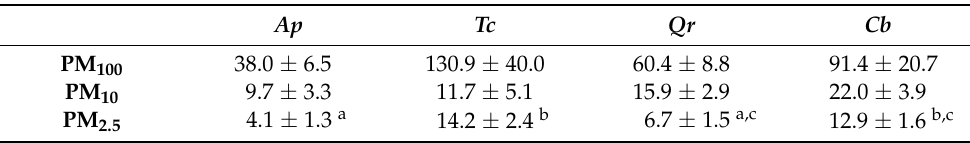
Table 2. Particulate matter (PM) fractions removed from leaves of A. platanoides ( Ap ), T. cordata ( Tc ), Q. robur ( Qr ), C. betulus ( Cb ) for the PM classes PM 100 , PM 10 , PM 2.5 . Data shown in mg PM · m − 2 leaf area ± standard error (SE). The letters mark the significant differences of an ANOVA performed within each PM class (one-way ANOVA, p <